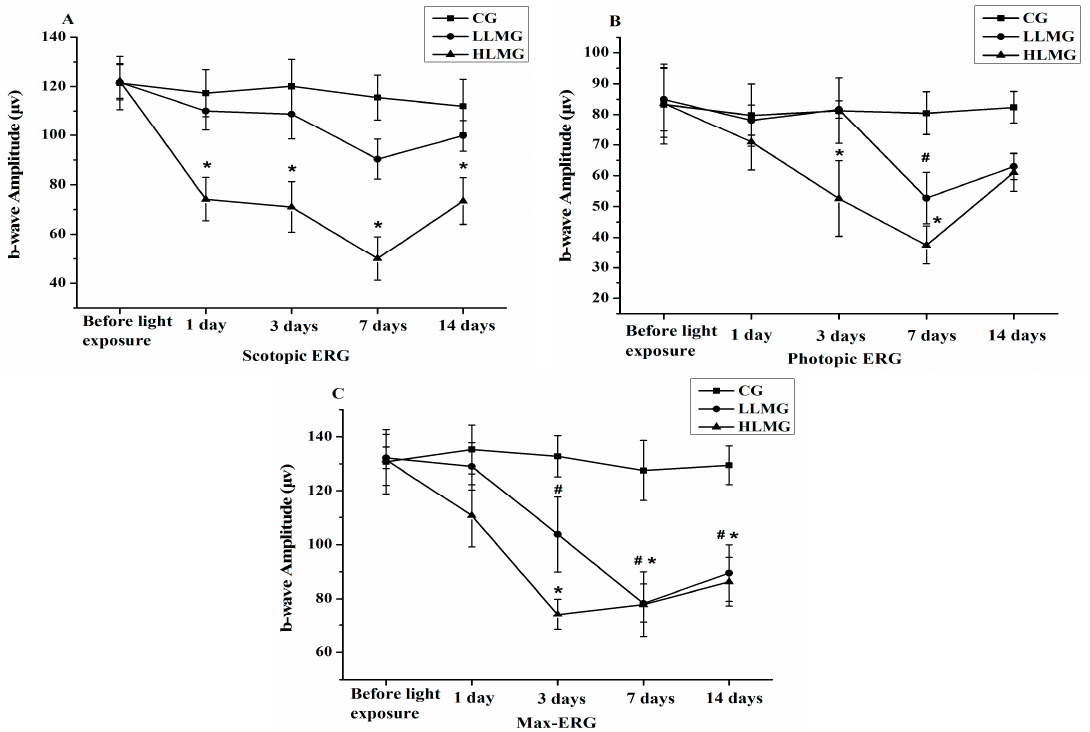
Figure 1. Values for the b-wave amplitudes of ( A ) scotopic; ( B ) photopic; and ( C ) max electroretinograms (ERGs) from retinas of rabbits in the CG, LLMG, and HLMG at 1 day before and 1, 3, 7, and 14 days after light exposure. Data are expressed as the mean ± standard deviation ( n = 8). # ,* p < 0.05 ( t -test). CG: no light exposure and vehicle administration; LLMG: 11,000 lx light exposure and vehicle administration; HLMG: 18,000 lx light exposure and vehicle administration.